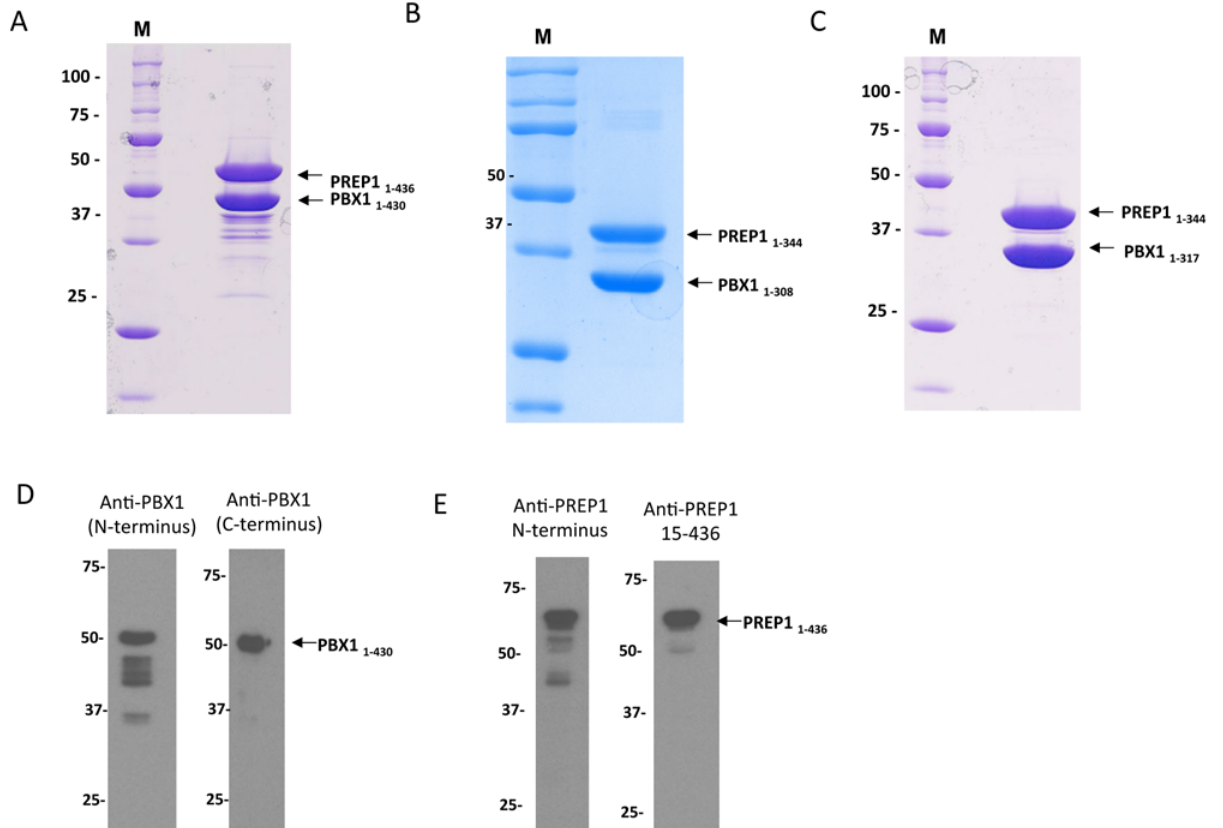
Fig 5. Electrophoretic migration of protein samples after three chromatographic steps. A, B, and C. 2 μ l of concentrated samples (at 10 mg/ml) of PBX1